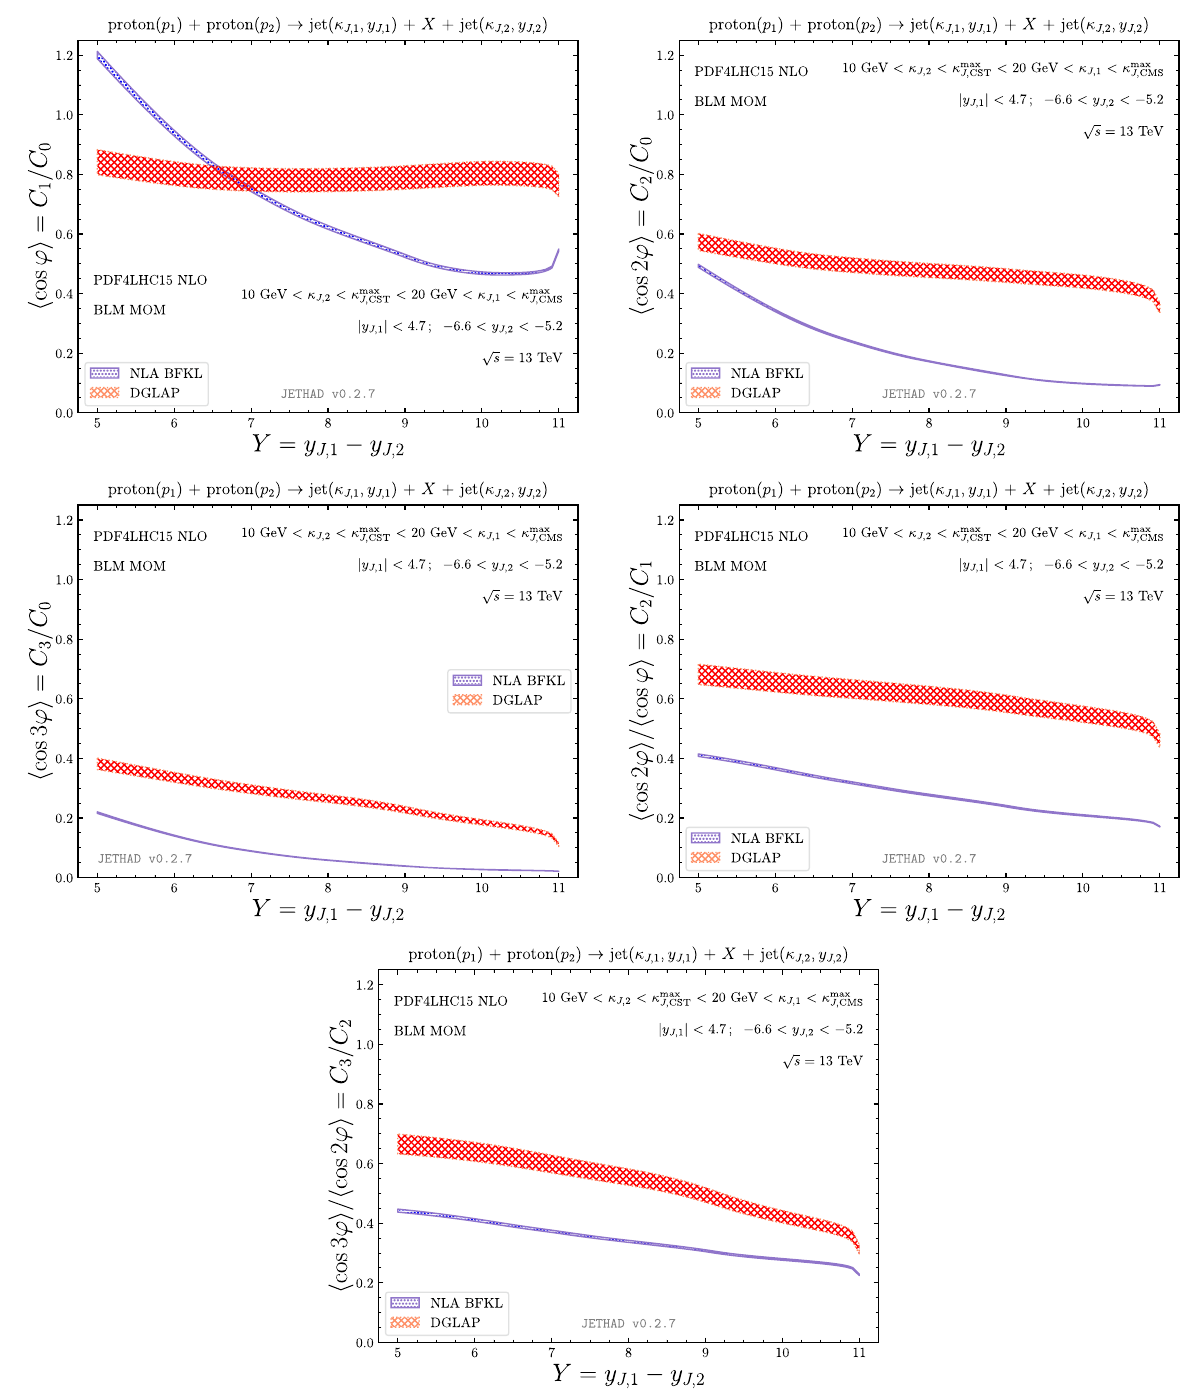
Fig. 12 Y -dependence of several azimuthal correlations, R nm ≡ C n / C m , of the Mueller–Navelet jet production (left panel of Fig. 2) √ s = 13 TeV ( CASTOR-jet configu- for μ F 1 , 2 = μ R = μ BLM and R